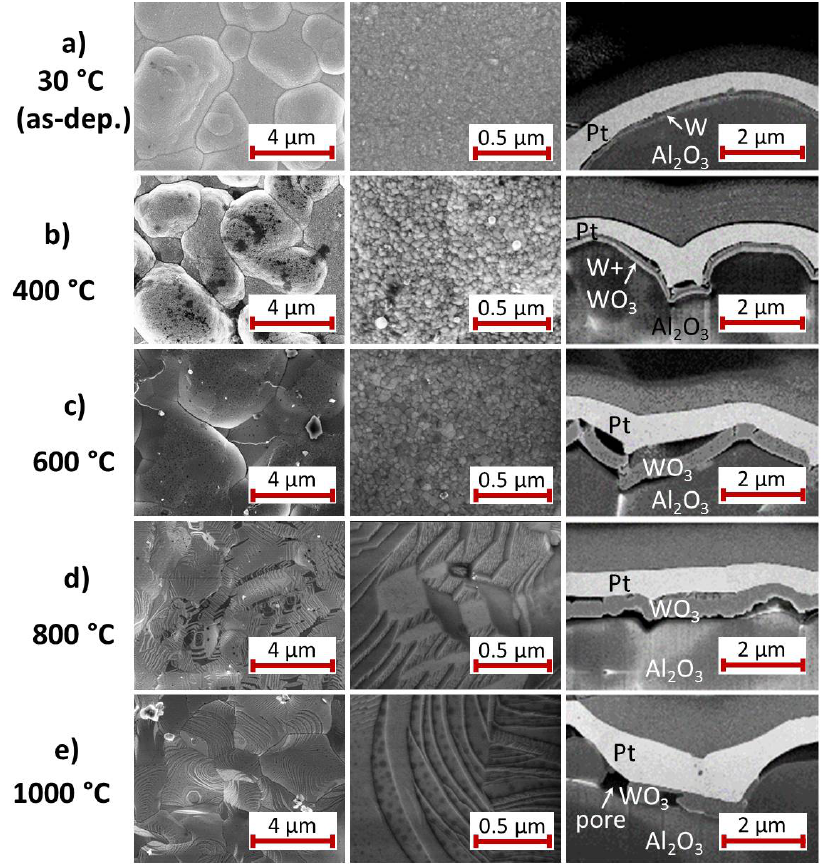
Figure 5. SEM images (InLens, 5 kV, 3 mm working distance) with two different magnifications of the surface of the electrodeposited Pt ∗ film on W seed layer ( a ) after deposition and after annealing for 2 h in air at ( b ) 400; ( c ) 600; ( d ) 800 and ( e ) 1000 ◦ C. On the right hand side a SEM image (InLens, 3 kV, 5 mm working distance) of the film cross-section is presented.